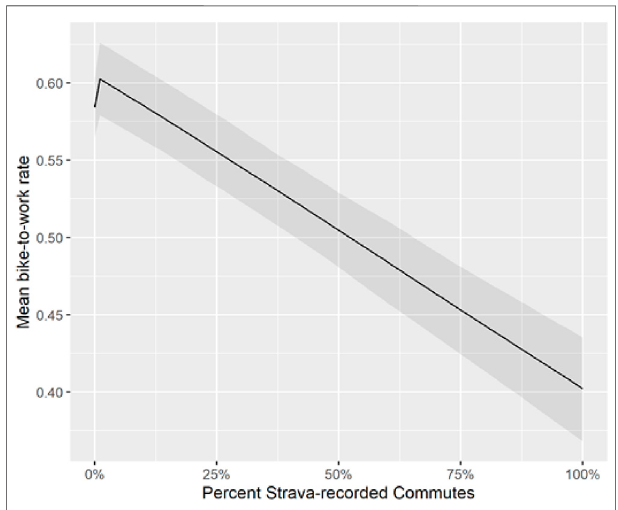
FIGURE 10 | Model predicted mean bike-to-work rate of bike-lending participants by use of Strava app integration.